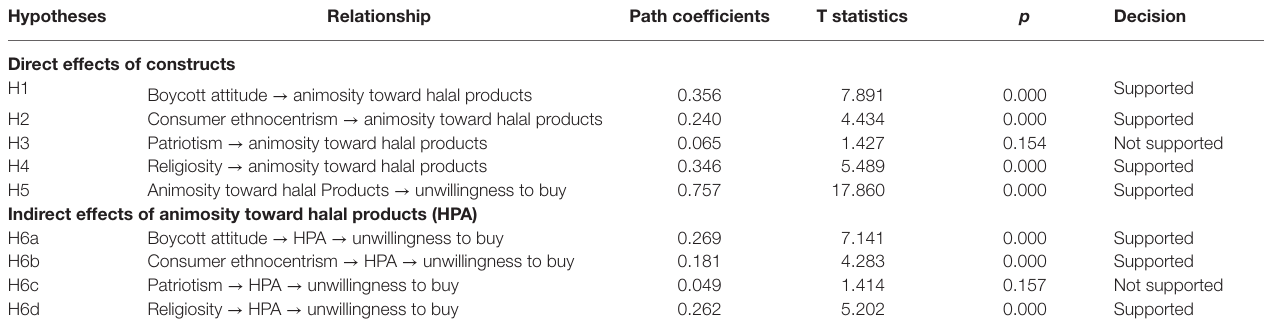
TABLE 5 | Path coefficient